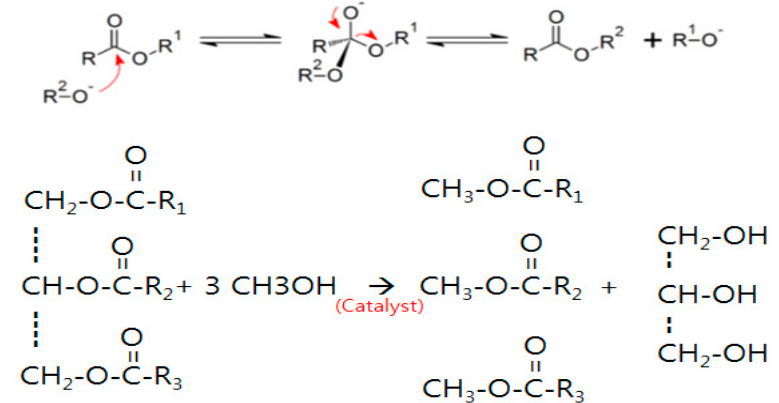
Figure 4. Schematic diagram of transesterification mechanism; where R 1 , R 2 , and R 3 are the long hydrocarbon chains (also called the fatty acid chains).